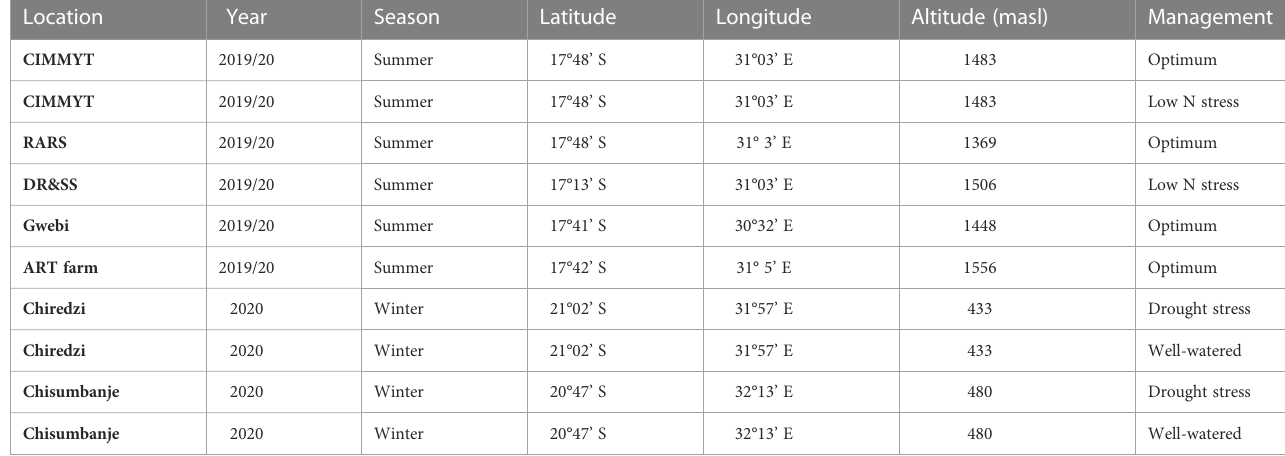
TABLE 2 Description of testing environments used for this study.